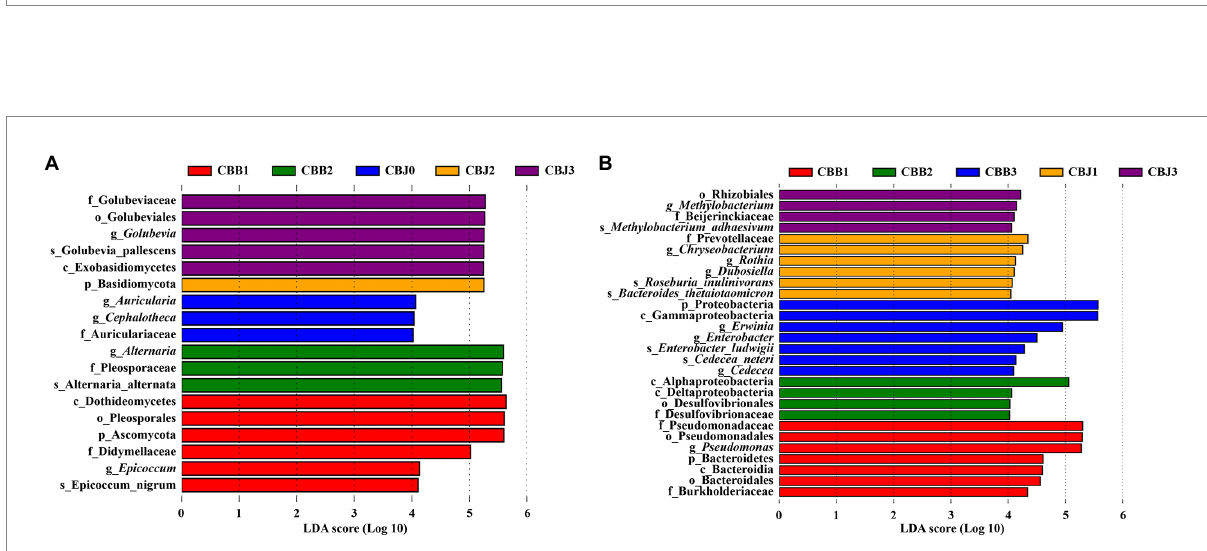
FIGURE 7 LEfSe analysis of microbial communities among tobacco leaves (symptomatic leaves CBB; asymptomatic leaves CBJ) at four sampling time points (0–3). (A) For fungal communities and (B) for bacterial